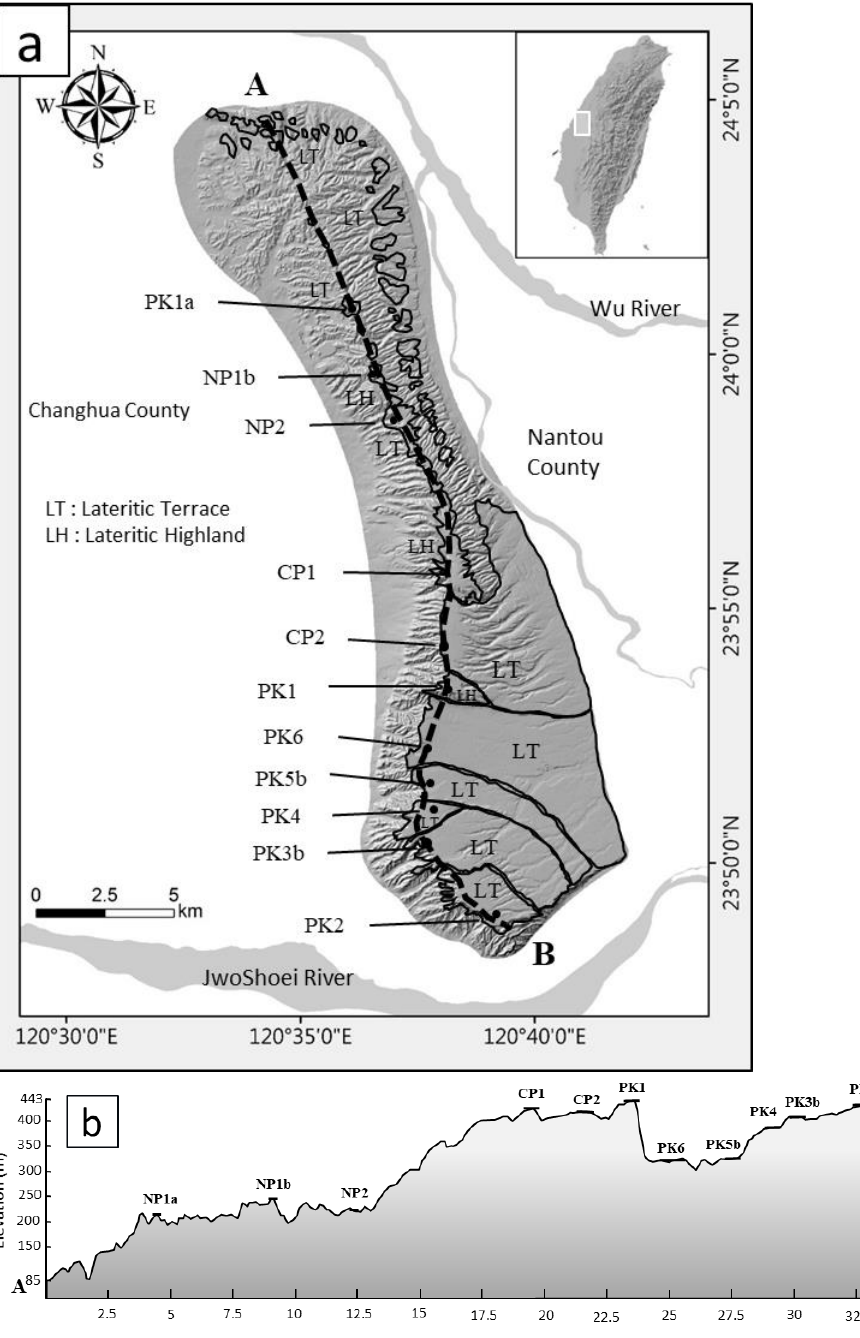
Figure 1. ( a ) Pakua tableland topographic map and sampling point, and ( b ) topographical profile (A–B) and soil age distribution.